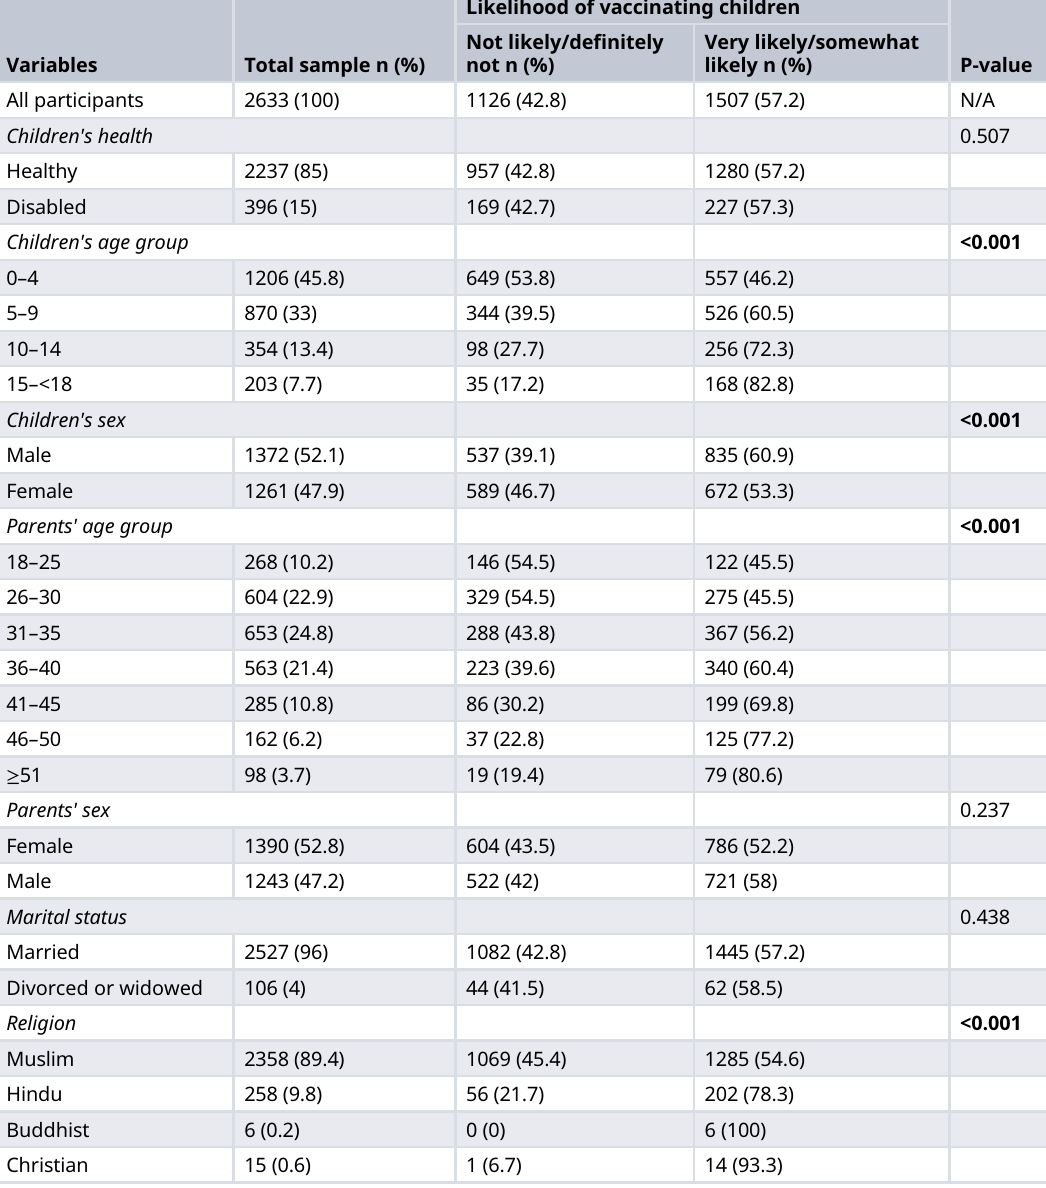
Table 1. Descriptive analysis: Sociodemographic characteristics, COVID-19 threat, and parental vaccine